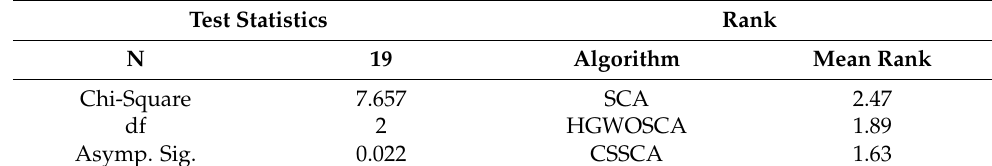
Table 2. Friedman test’ results for the 19 test functions.